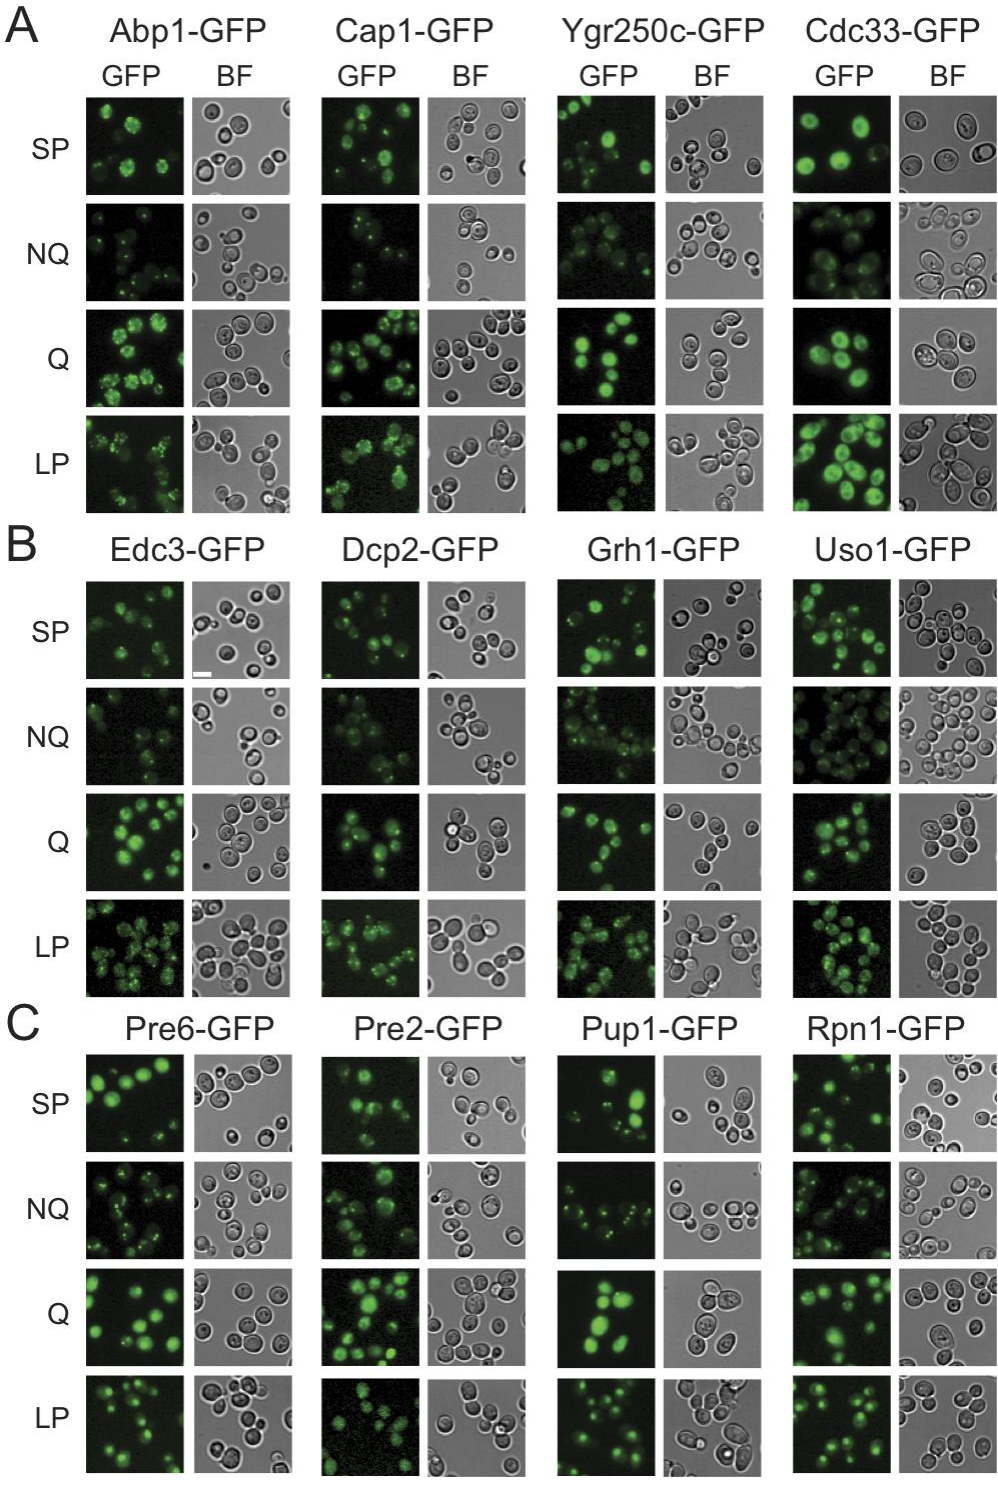
FIGURE 1: Differential formation of stationary phase-specific granules in Q and NQ cells. Yeast strains carrying the GFP-tagged genes were grown in YPD for 5 days to enter stationary phase and then cells were fractionated using the Percoll gradient to isolate the Q (in the lower layer) and NQ cells (in the upper layer). The fluorescence images of total stationary phase cultures (SP) and the fractionated cells (Q and NQ) from the same strain are shown under identical brightness and contrast settings. Log-phase (LP) images were taken from exponential cell cultures whose OD 600 values were between 0.4 and 0.6. Scale bar: 5 μm. BF: brightfield. (A) Components of the actin body (Abp1 and Cap1) and stress granule (Ygr250c and Cdc33). (B) Components of the P-body (Edc3 and Dcp2) and CUPS (Grh1 and Uso1). (C) Components of the proteasome storage granule (Pre6, Pre2, Pup1 and Rpn1). In most strains, the GFP intensity of granule marker proteins appears to be stronger in Q cells, which is probably due to the fact that the genes encoding these marker proteins have a higher mRNA abundance in Q cells